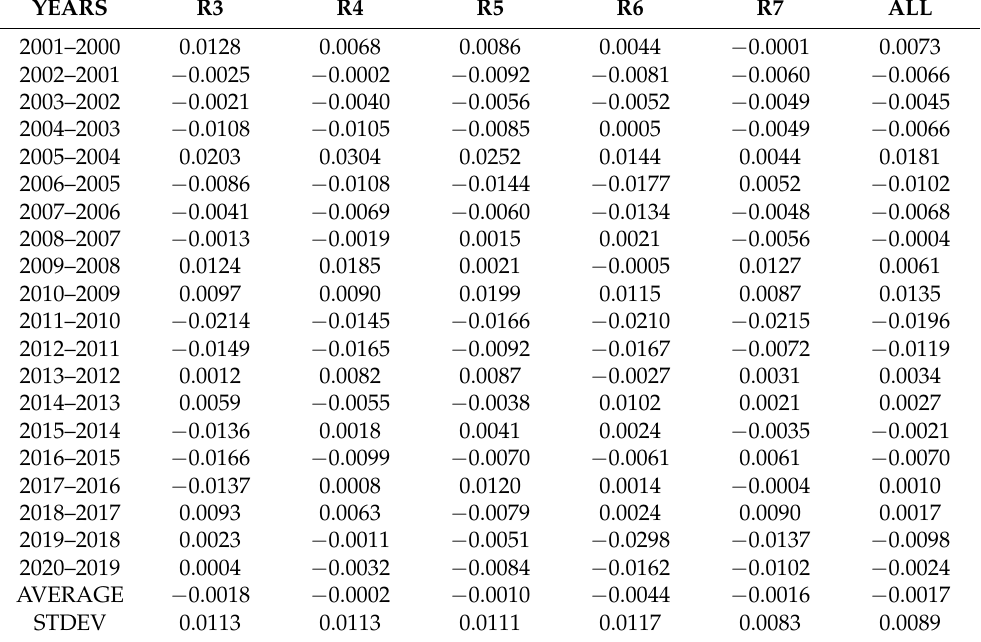
Table A2. Differences in EVI2 demonstrating positive or negative ( − ) change in VI measured from one year to the next showing the average peak growing season, 1 May and October 30, values for each reach and the total weighted average in All reaches between 2000 and 2020 for the Lower Colorado